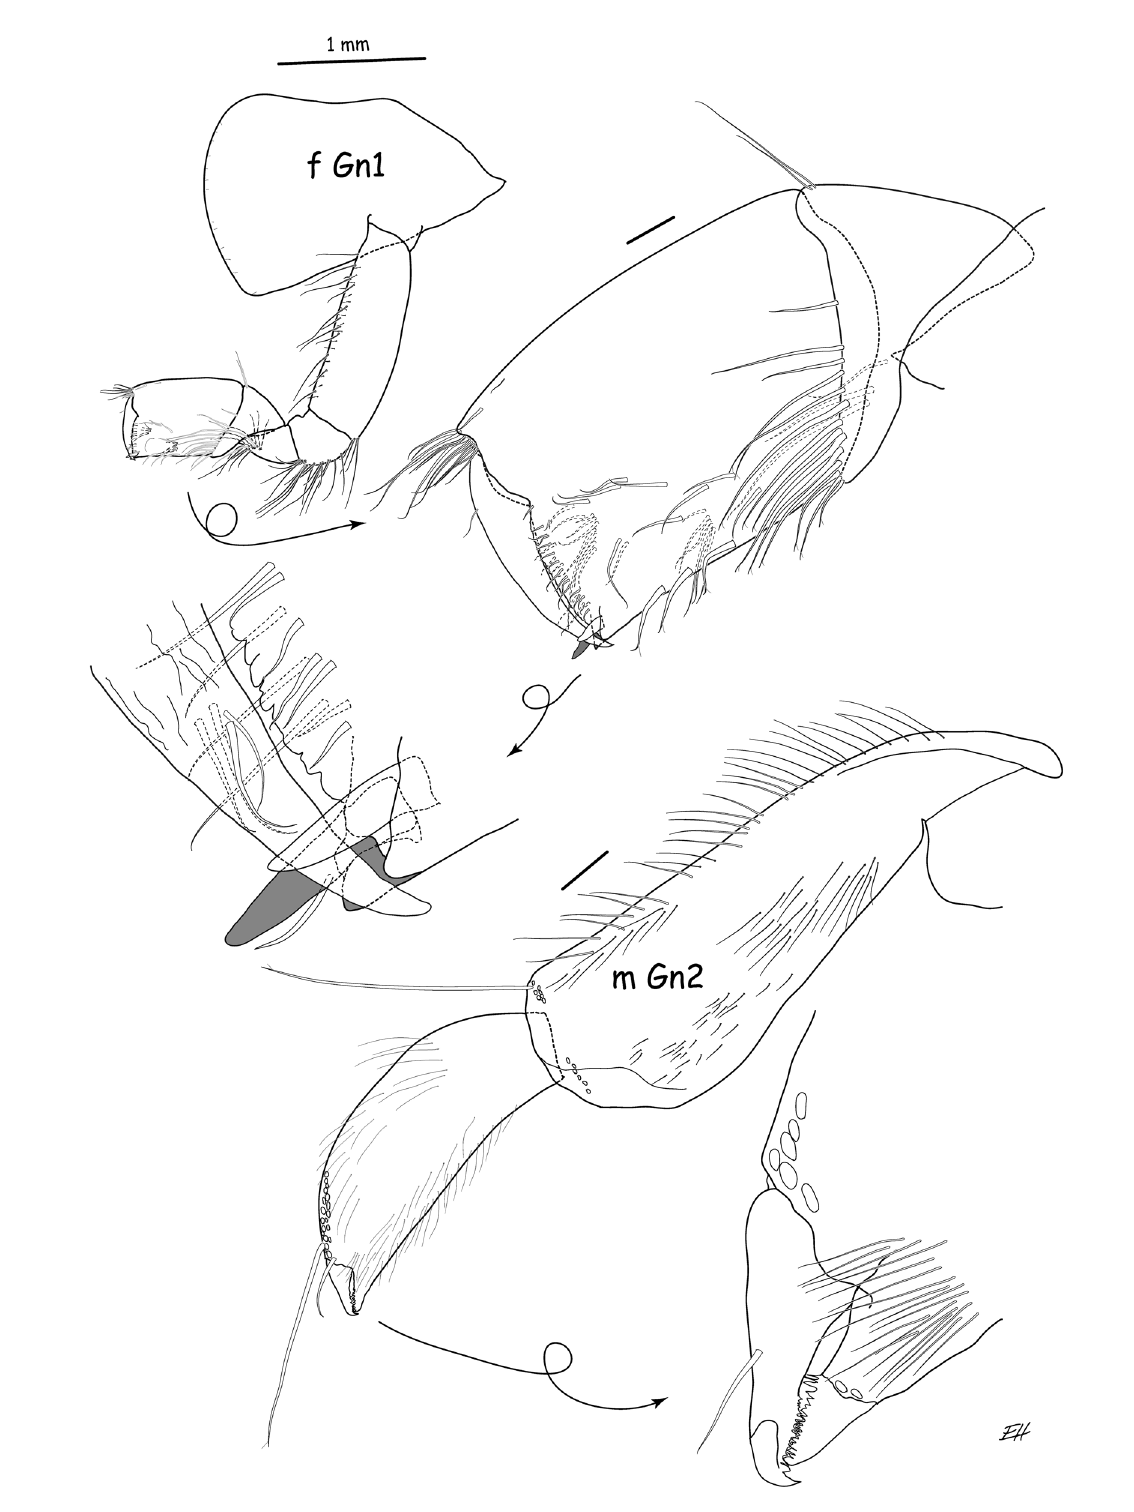
Fig. 22. Abyssorchomene scotianensis (Andres, 1983), ♀, 12 mm (CMNC 2022-0005); ♂, 12.4 mm (CMNC 2022-0007). Rows of distal pectinate setae omitted on Gn2 propodus of male. Scale bars = 0.1 mm unless indicated